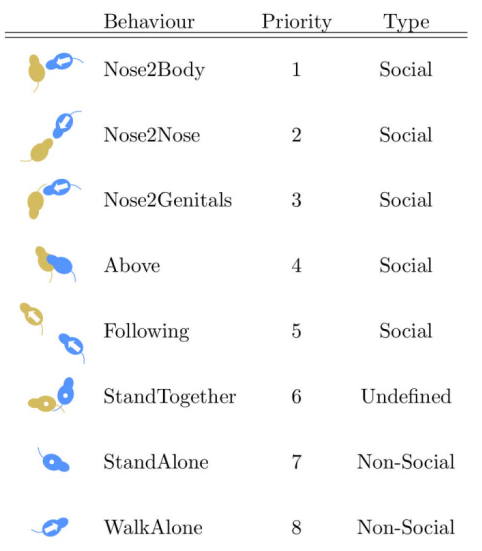
Figure 1. Behaviour priorities employed to combine all pairwise classifiers h a ) b in order to describe the behaviour of a mouse with a single class. ‘‘1’’ is the highest priority. The blue mouse is the one actively performing the action. An arrow indicates movement, a circle the lack thereof.